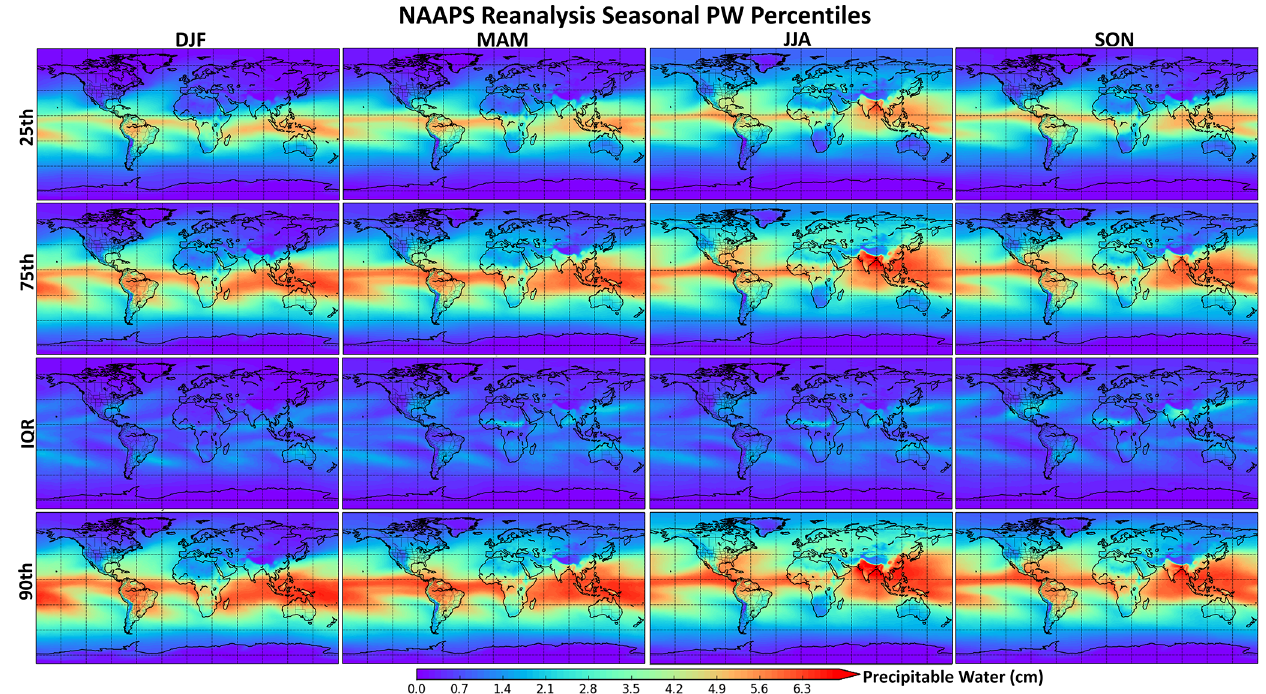
Figure 6. NAAPS-RA PW percentiles by season (DJF, MAM, JJA, SON). The 25th and 75th percentiles are shown, along with the interquar- tile range (IQR). The 90th percentile is used to show high PW values at a given